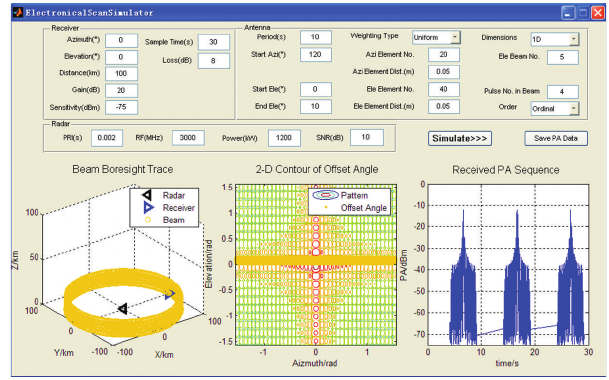
Figure 1: An example screen of the ES pattern